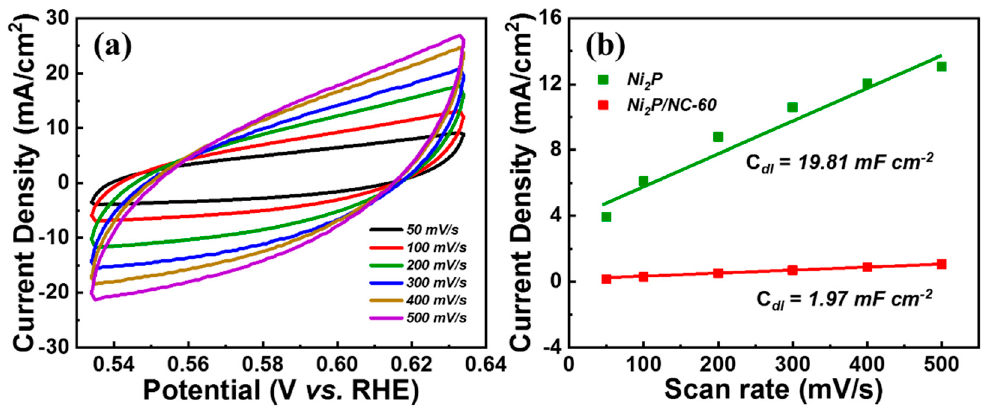
Figure 6. ( a ) CV curves for C dl at different scan rates (50 – 500 mV s-1) of Ni 2 P/NC-60 in 1 M KOH; ( b ) Electrochemical double layer capacitance (C dl ) at 0.584 V vs. RHE of Ni 2 P and Ni 2 P/NC-60.